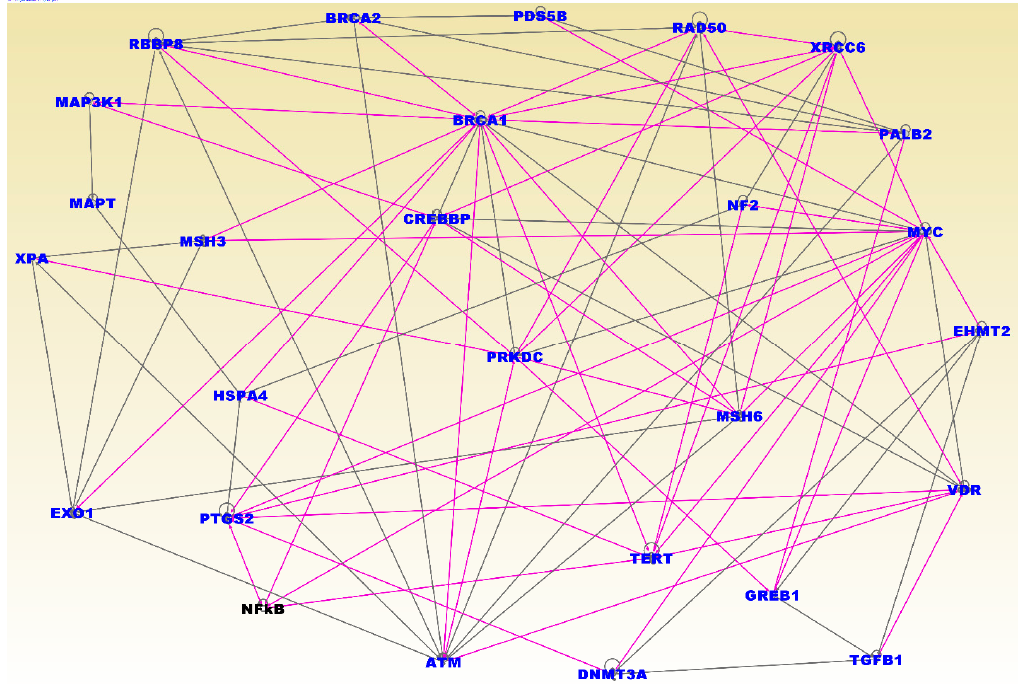
Figure 5. Network analysis showing interactions and functional relationships among the 237 genes containing both germline and somatic mutations. All genes in blue font contained both germline and somatic mutations and were significantly differentially expressed between patients with TNBC and controls. Many of these genes were also found to interact with the NF-kB complex (black font). The line colors indicate overlap in functional relationships among genes in different networks. Note that in the networks there are fewer genes than the input genes due to filtering that we imposed on the networks to remove spurious interactions and less significant networks.